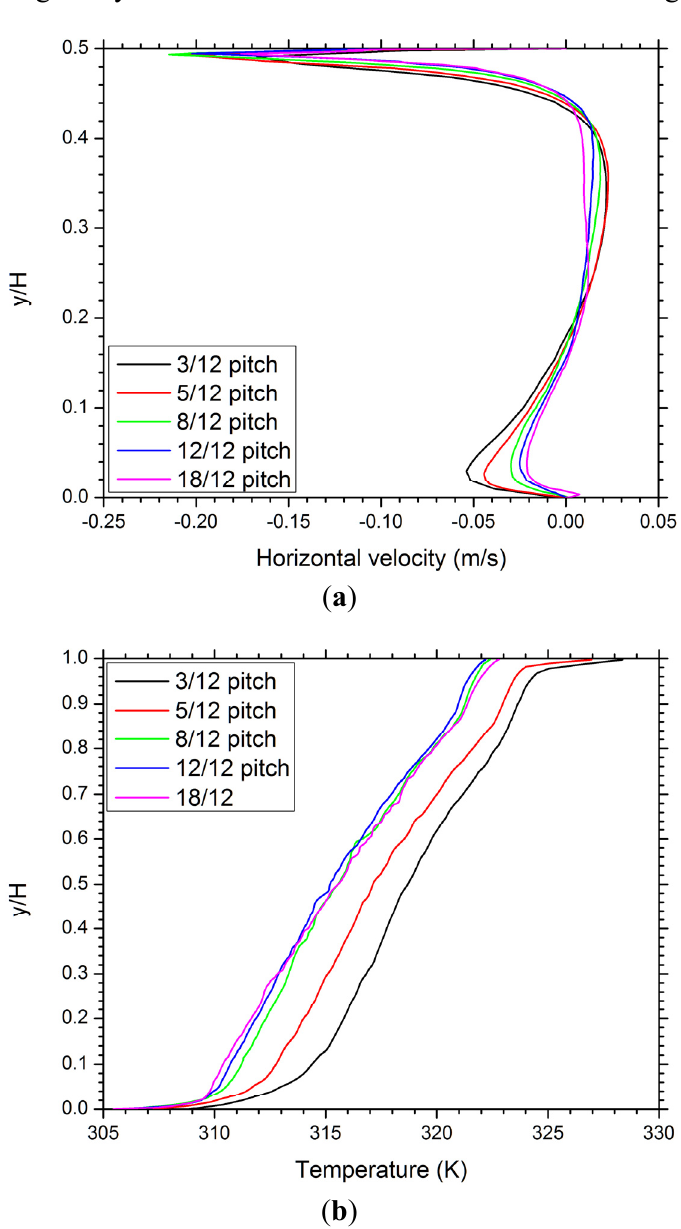
Figure 6. Predicted profiles of ( a ) horizontal velocity along the vertical line x = 2 m